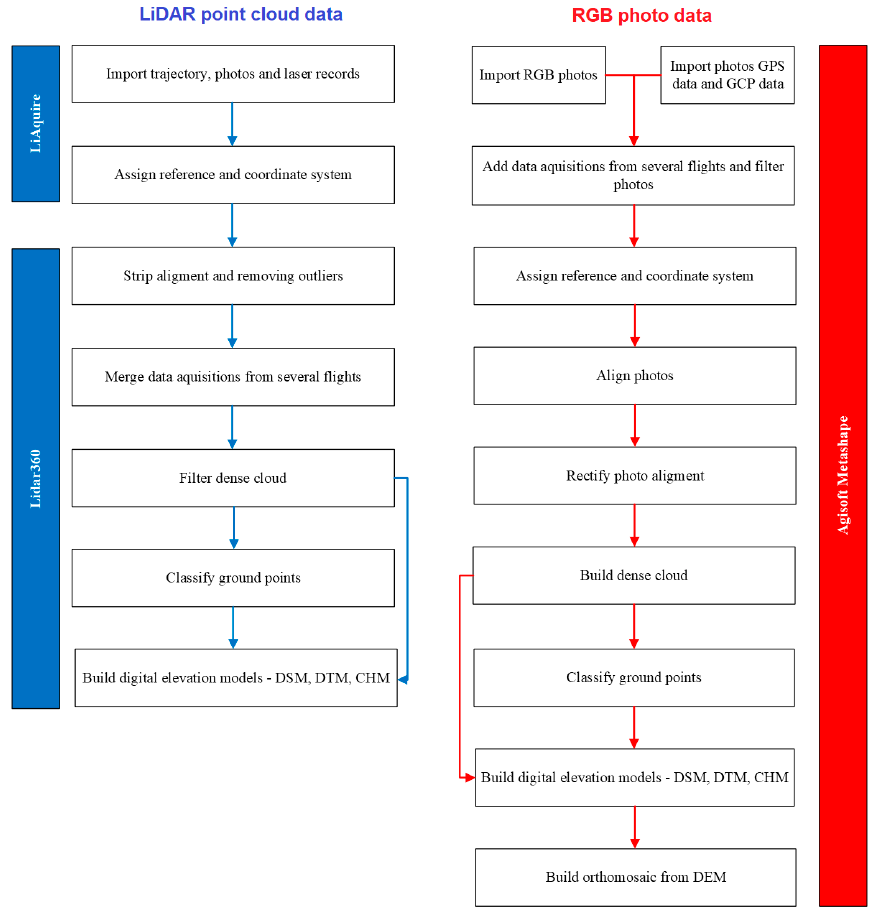
Figure 5. Flowchart of data processing as regards data obtained from the UAV platform—laser scanning point cloud processing and photogrammetric procedures, used to generate DEMs.